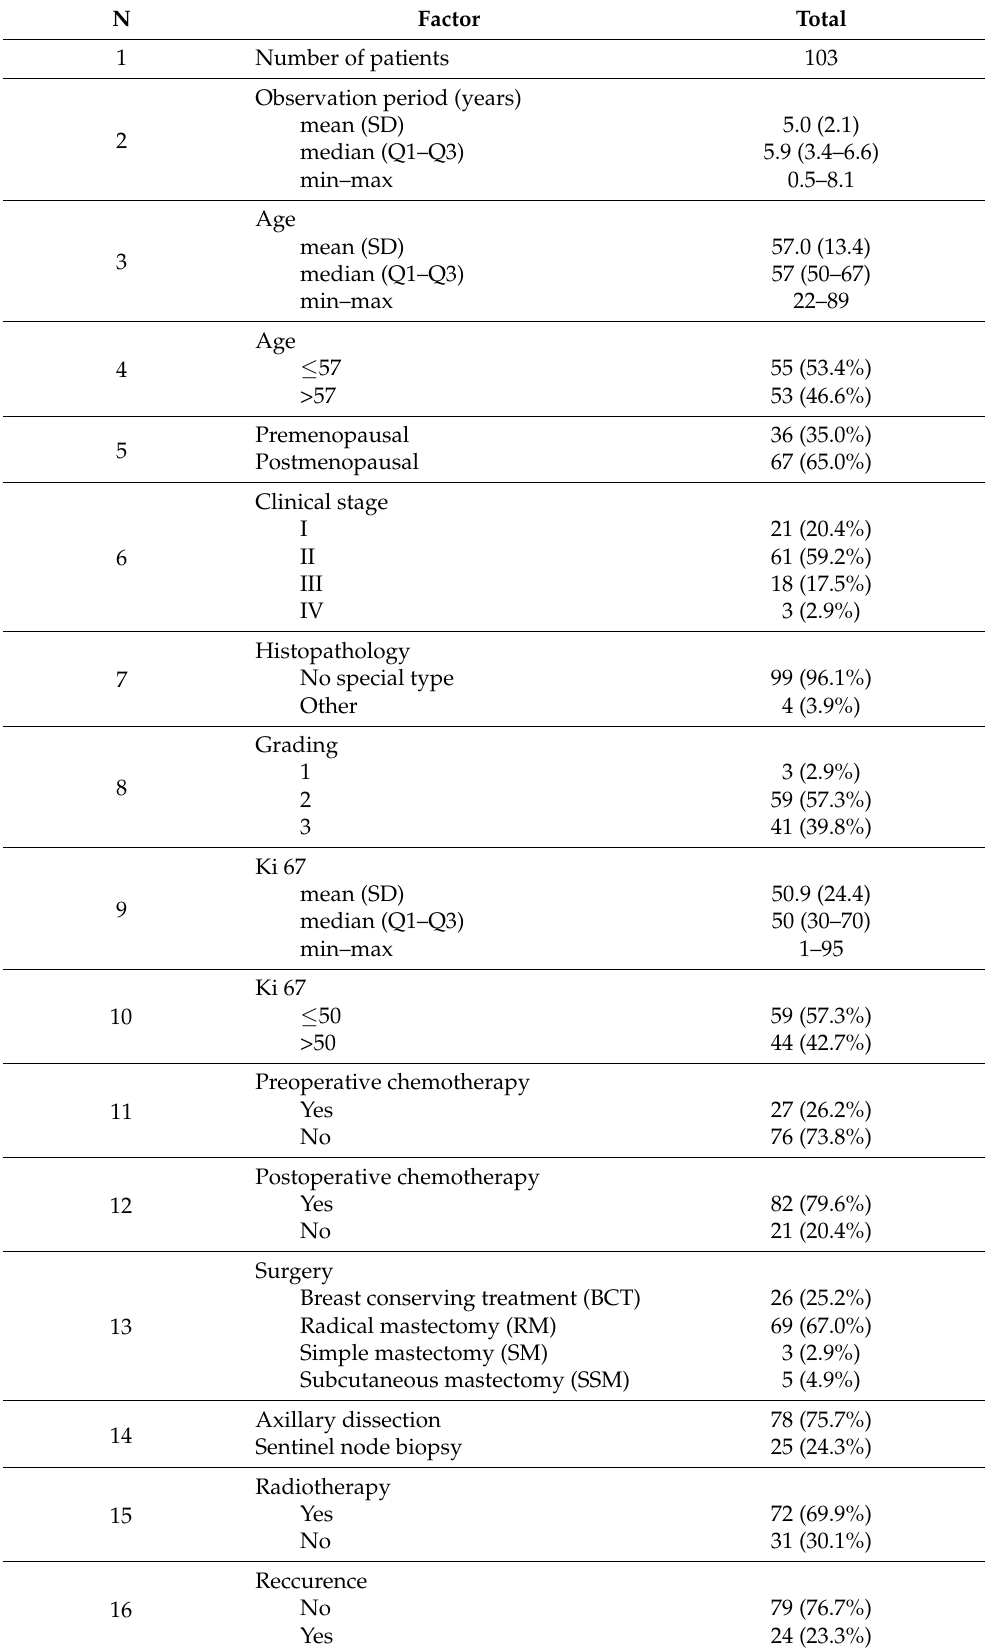
Table 1. Characteristics of study